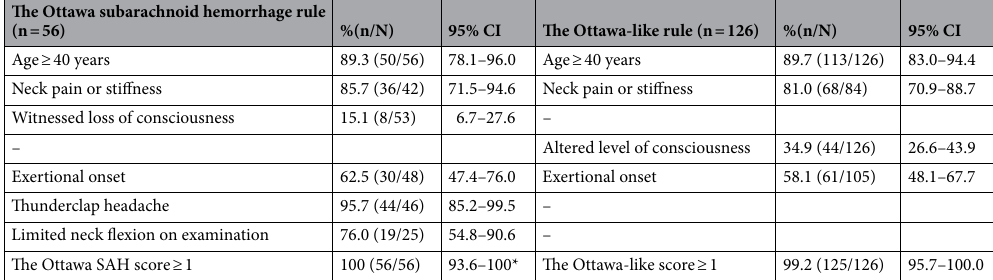
Table 3. The sensitivity of the Ottawa subarachnoid hemorrhage rule and those of the Ottawa-like rule and each criterion. Missing (OSAH rule): Neck pain or stiffness = 14; Witnessed loss of consciousness = 3; Exertional onset = 8; Thunderclap headache = 10; Limited neck flexion on examination = 31. Missing (Ottawa- like rule): Neck pain or stiffness = 42; Exertional onset = 7. SAH, subarachnoid haemorrhage. *97.5% CI, one-